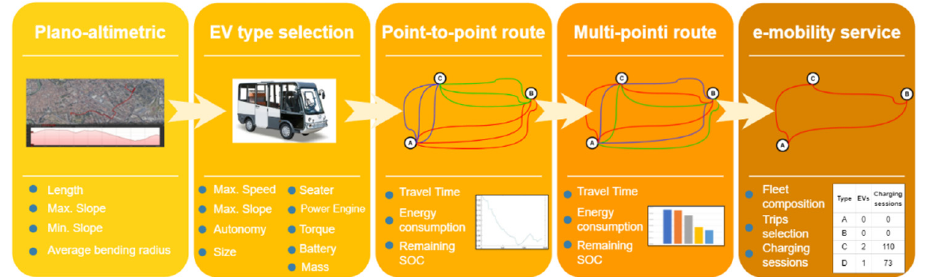
Figure 2. 5-step methodology for e-mobility service for people with disabilities; outputs of each step are reported in the relevant bulleted list.